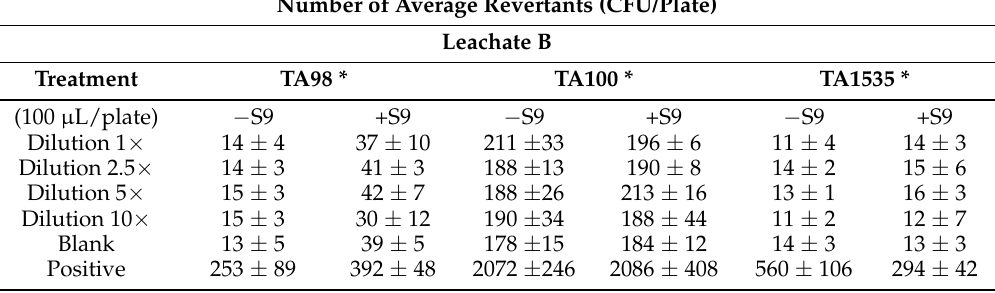
Table 9. Revertant frequency of Salmonella tester strains TA98, TA100, and TA1535 following incubation with leachate B from BA in presence and absence of S9 mix (mean ± SD is shown).